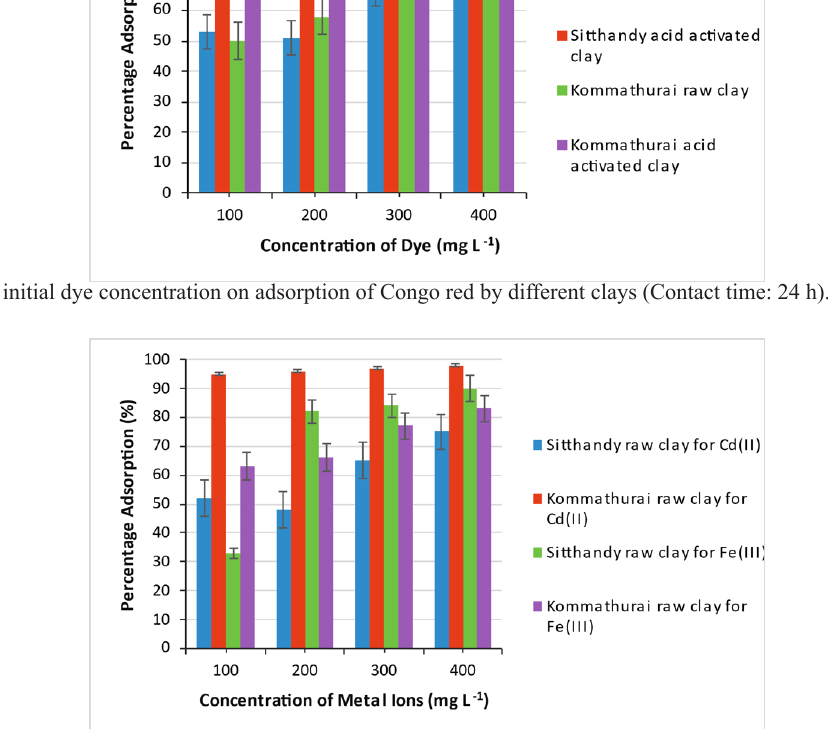
Figure 6: Effect of initial concentration of heavy metal ions on adsorption by different clays. (Contact time: 24